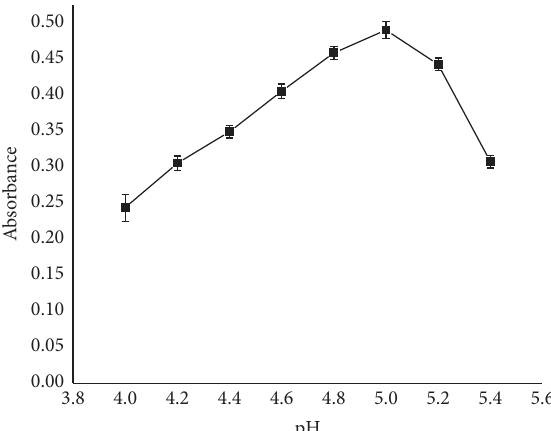
Figure 5: pH effect on the determination of fluoride using EBT as a spectrophotometric reagent (conditions: concentration of aluminum and EBT: 5.0 × 10 − 5 M and reaction time: 24h).